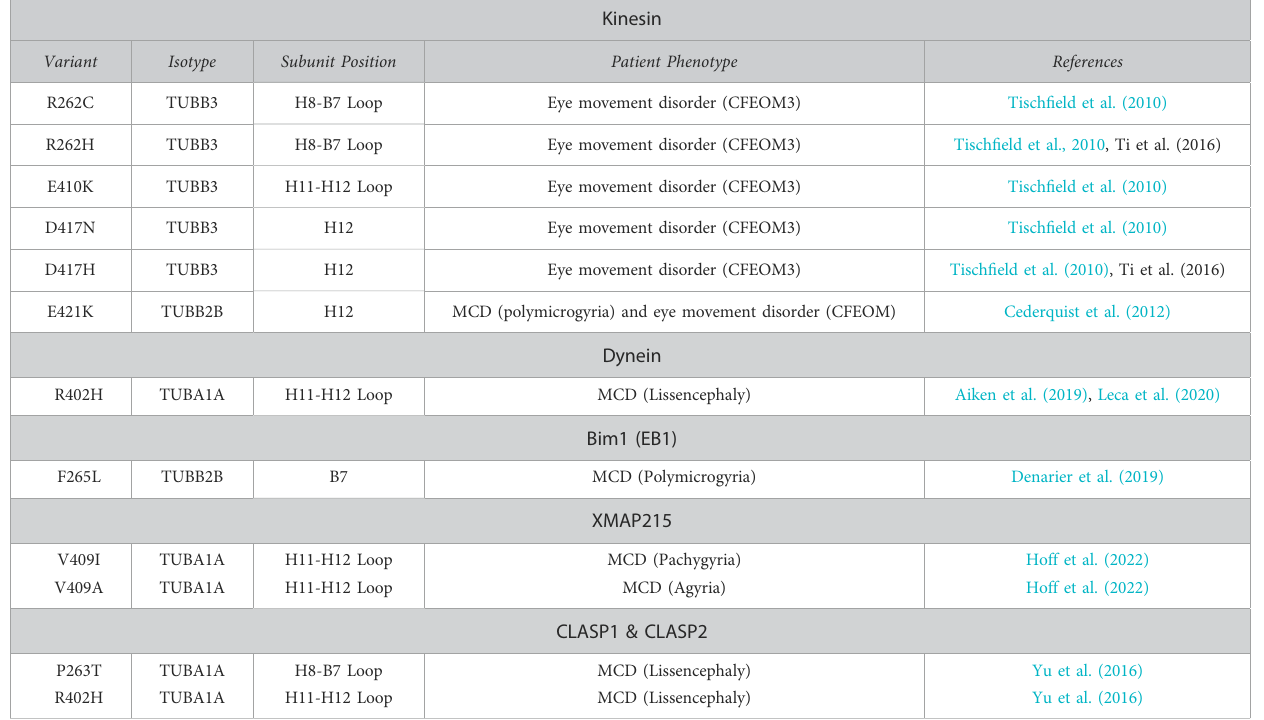
TABLE 1 Tubulin gene variants shown to affect MAP interaction. H = alpha-helix; B = beta-strand; CFEOM3 = Congenital Fibrosis of the extraocular muscle; CFEOM3 = Congenital Fibrosis of the extraocular muscle type 3; MCD = Malformations of cortical